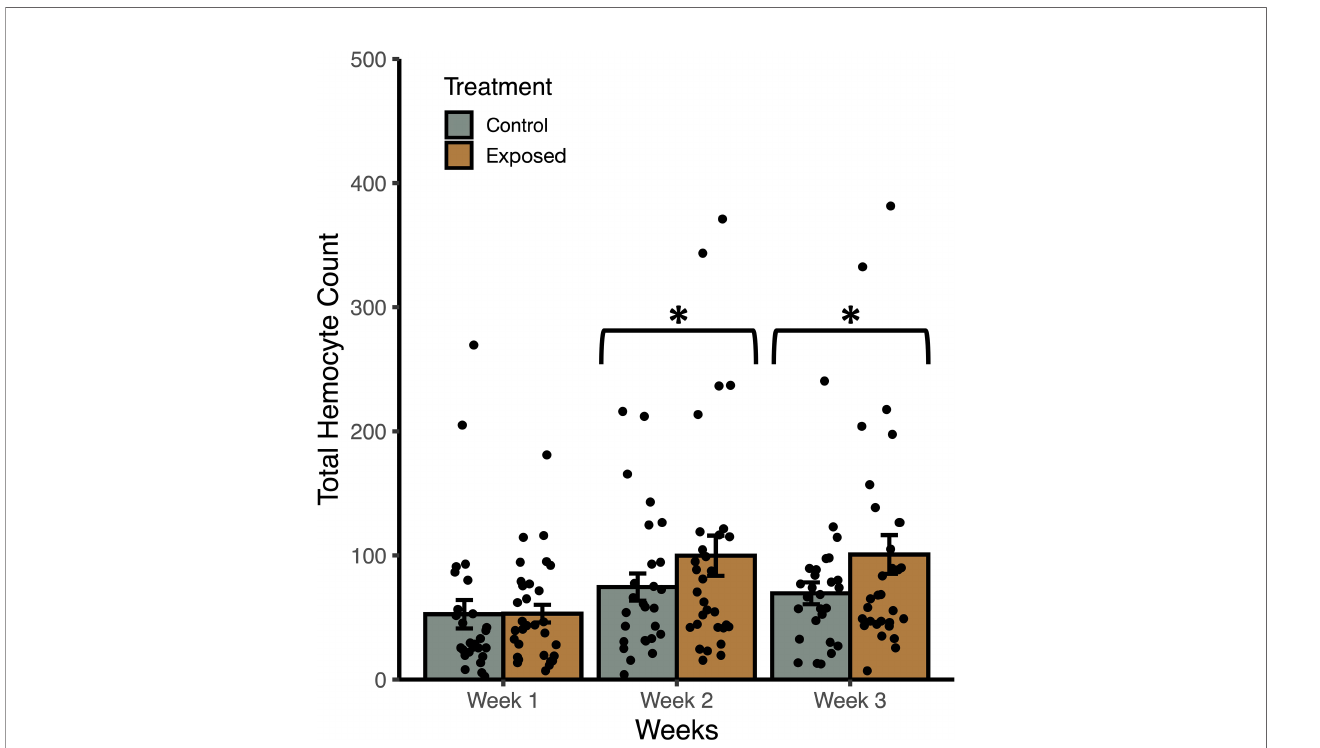
FIGURE 3 | Weekly mean total haemocyte counts (± SE) from uninfected Stagnicola elodes snails raised in experimental (snail-conditioned water) and control water. * P < 0.05.